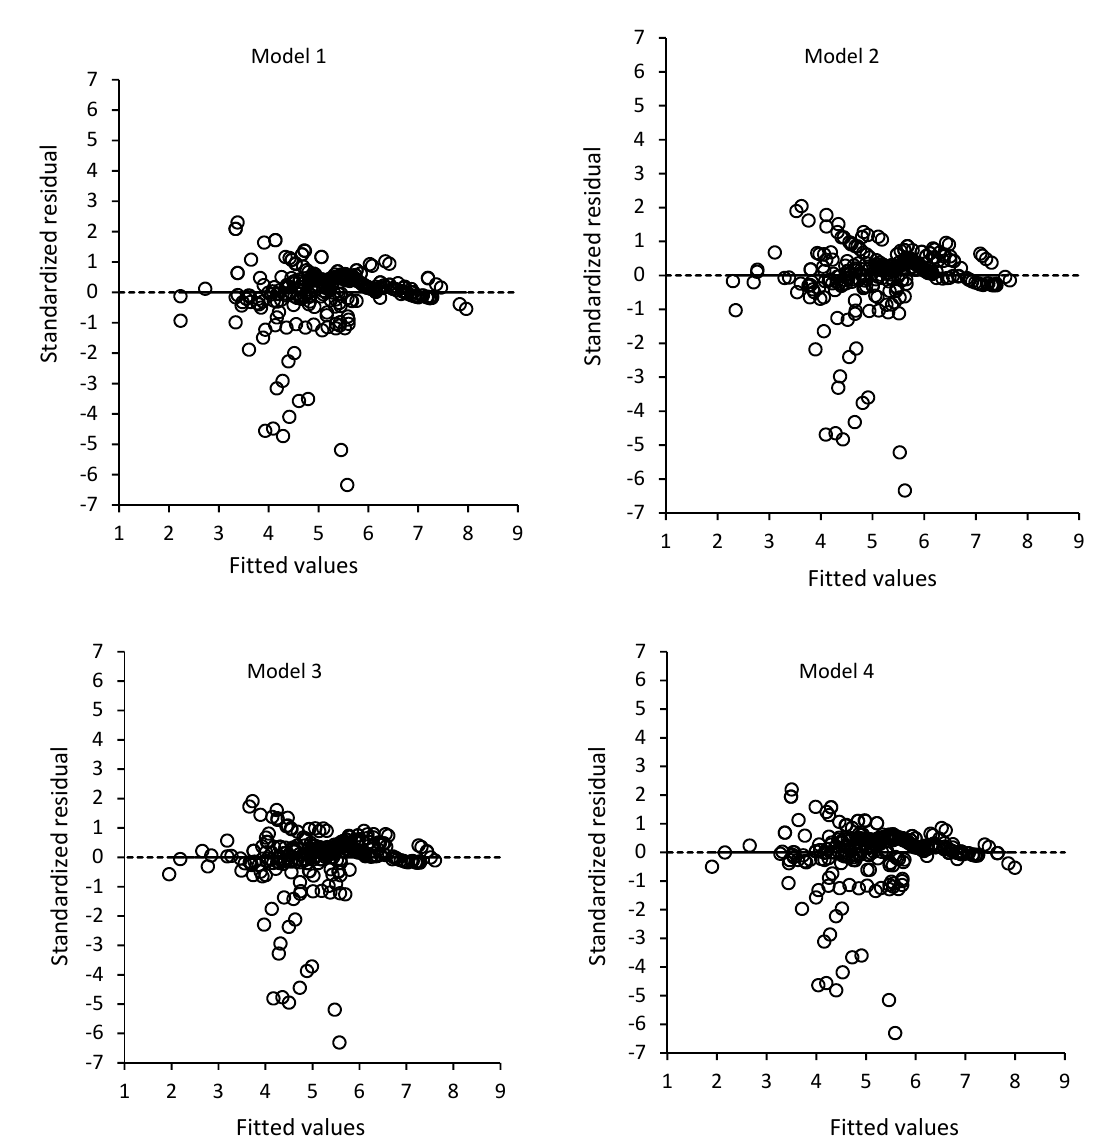
Figure A2. Plots of standardized residuals against the fitted values on the logarithmic scale